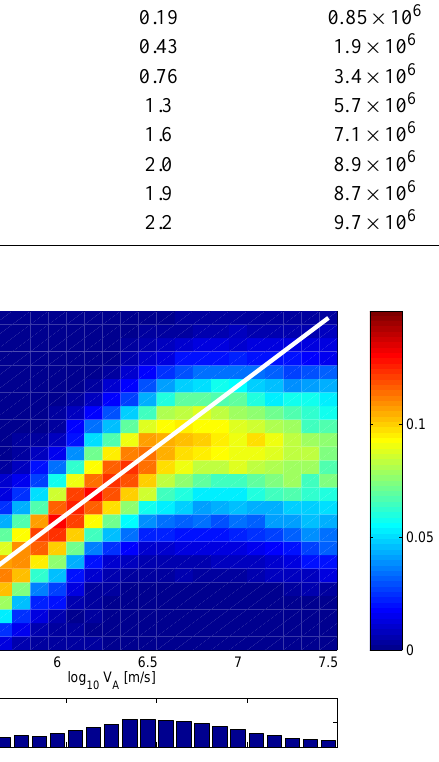
Fig. 8. Upper panel: the calculated Alfv´en velocity [logms − 1 ] for each interval of E/B [logms − 1 ]. The color bar shows the occurrence frequency. Each column is normalized, that is, the sum of the values of all bins in a column is 1. The white line corresponds to the case when the phase velocity E/B and the calculated Alfv´en